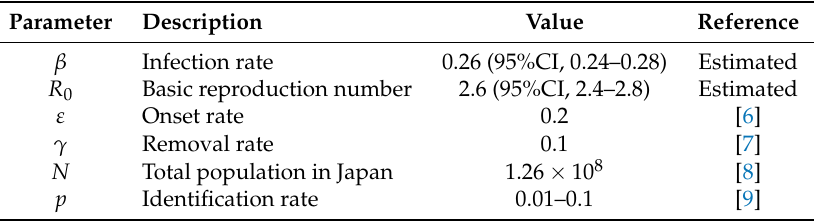
Figure 1. Comparison of Y ( t ) with the estimated infection rate β and the number of daily reported cases of COVID-19 in Japan from 15 January ( t = 0) to 29 February ( t = 45). Table 2. Parameter values for model Equation